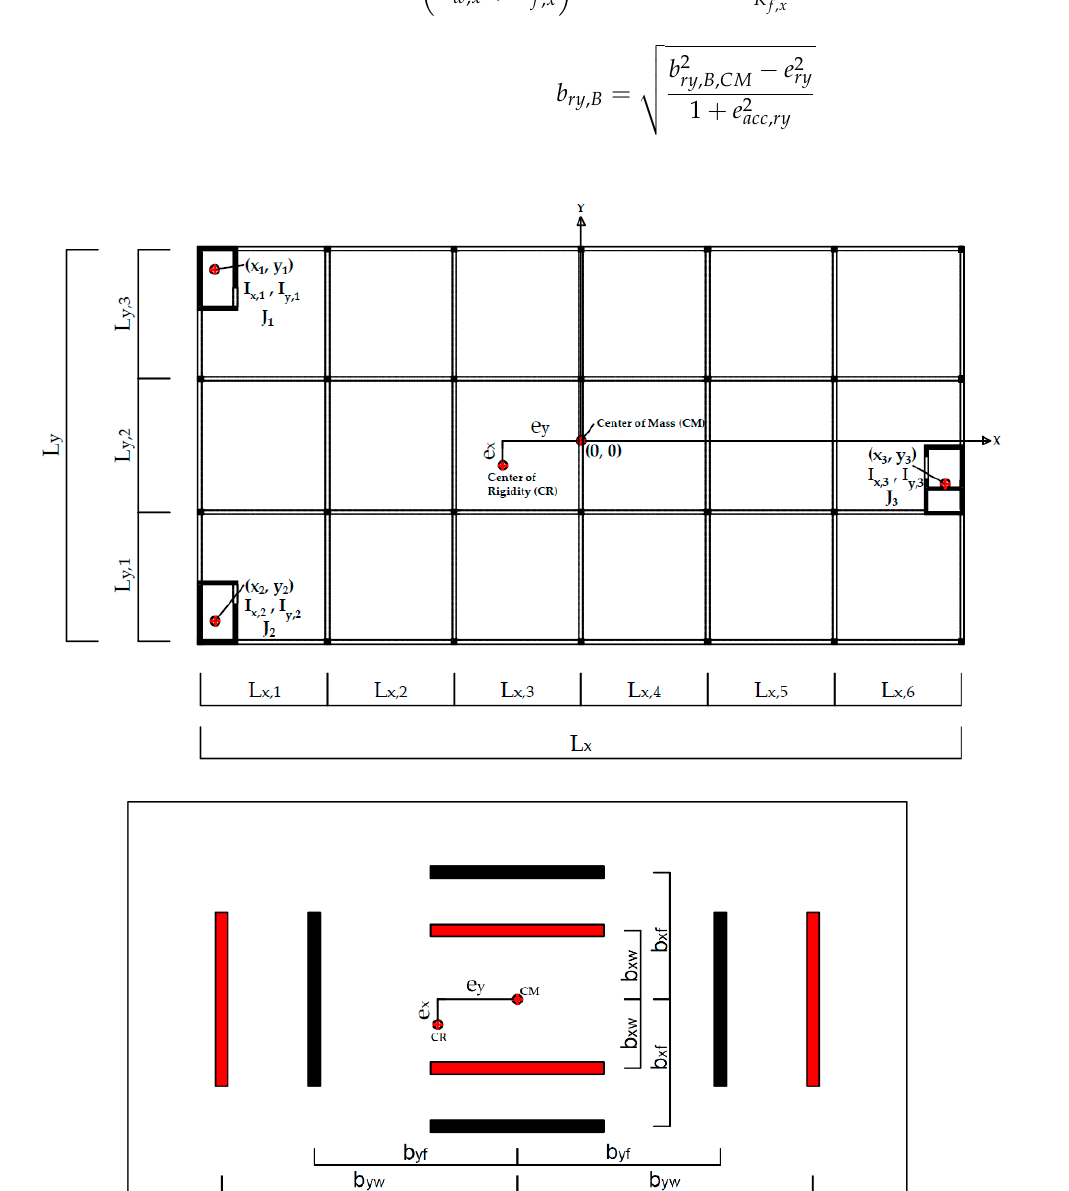
Figure 3. Dual system and the equivalent idealized pairs providing torsional stiffness through bending. ( a ) A dual system with structural details showing the disposition of frames and shear walls. ( b ) Dual system idealized into pairs of pure SW system (red) and pure moment resisting frame (MRF) system (black) in each direction showing the distances of the idealized elements from the center of mass (CM).